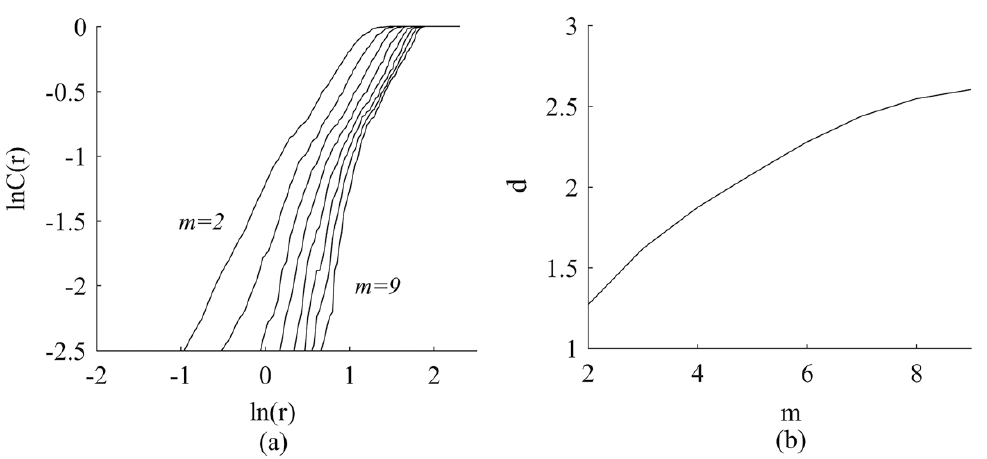
Figure 4. ( a ) a plot of ln( 𝑟 ) versus ln( 𝑟 ) and ( b ) the correlation dimension ( 𝑑 ) versus embedding dimension ( 𝑚 ).